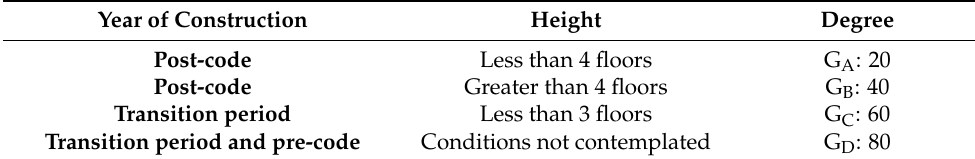
Table 6. Degree of vulnerability by number of floors.